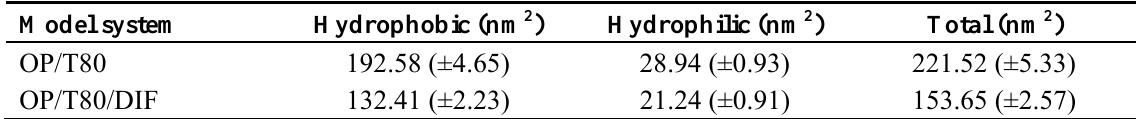
Table 2. A summary of the hydrophobic, hydrophilic, and total solvent accessible surface area (SASA) values of three model systems, averaged per molecule of Tween80 for the last 500 ps of both